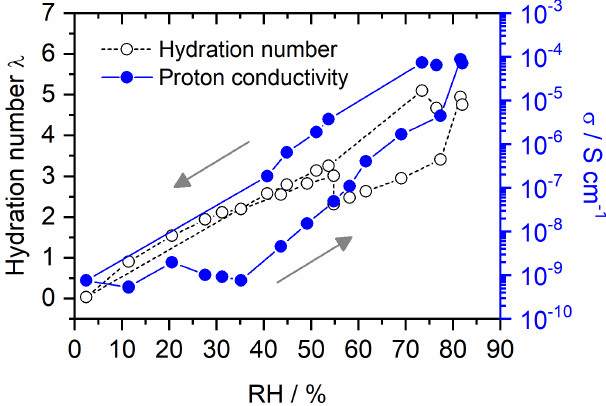
Figure 7. Resonance frequency f R and RH of the SPEEK film with DS = 0.9 in an equilibrated state as it is used to determine the mass change at each RH level. The data shown in this graph are an aug- mentation of the corresponding segment shown in Fig. 6.